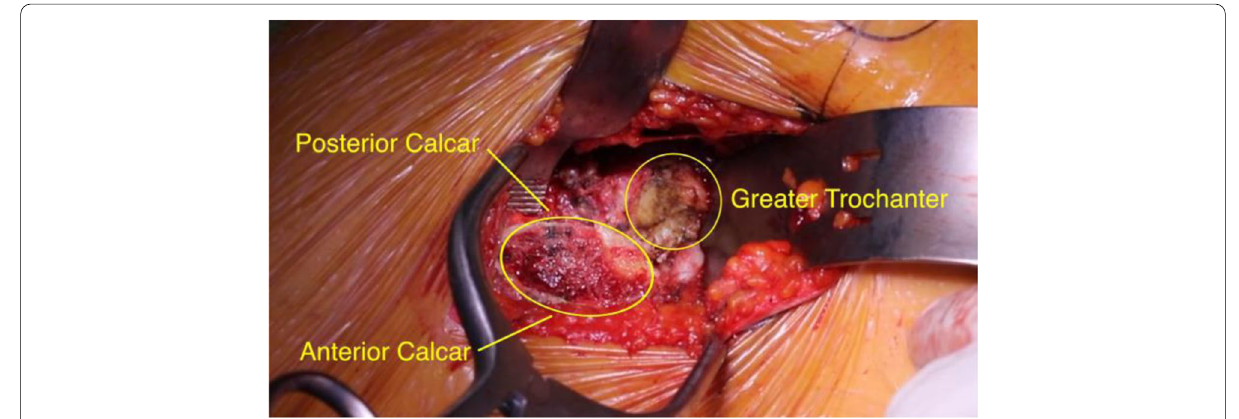
Fig. 9 Anatomical view of the calcars and greater